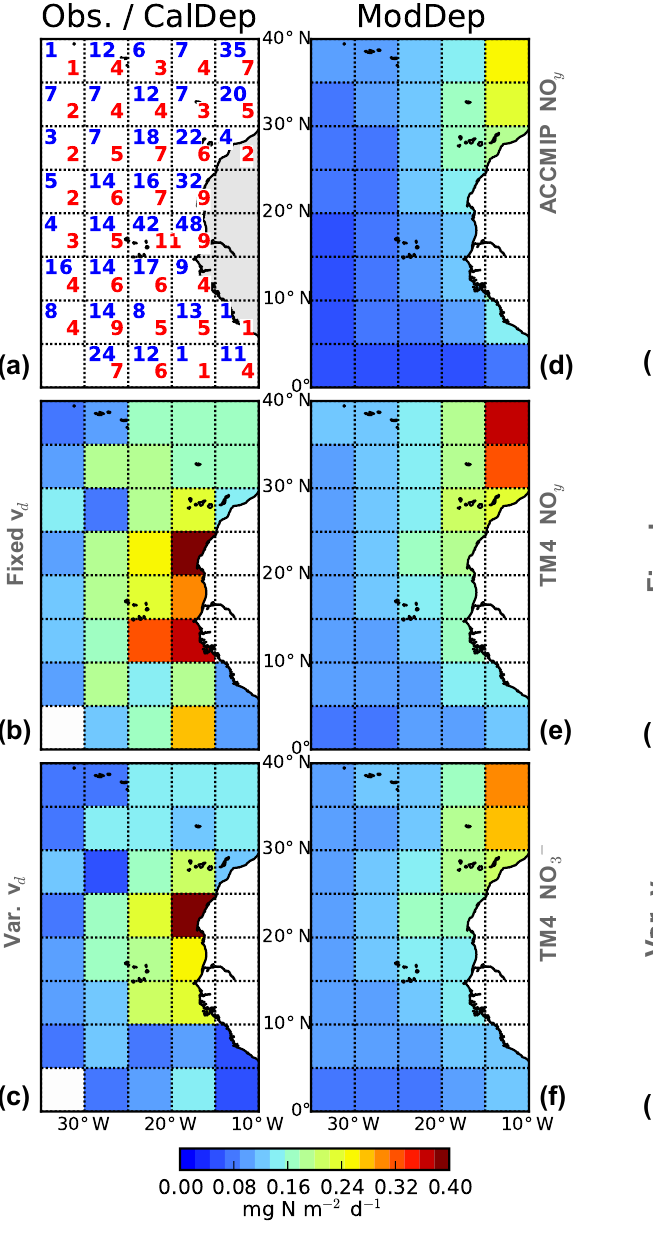
/NO y for Figure 9. Dry deposition fluxes (mg Nm − 2 d − 1 ) for NH + 3 the TEAtl region. Panels show (a) number of samples per grid cell (upper left, blue) and number of calendar months represented by CalDep calculated using the observations (lower right, red), NH + 3 (b) fixed v d and (c) variable v d methods, (d) NH x ModDep from ModDep from ACCMIP, (e) NH x ModDep from TM4 and (f) NH + 3